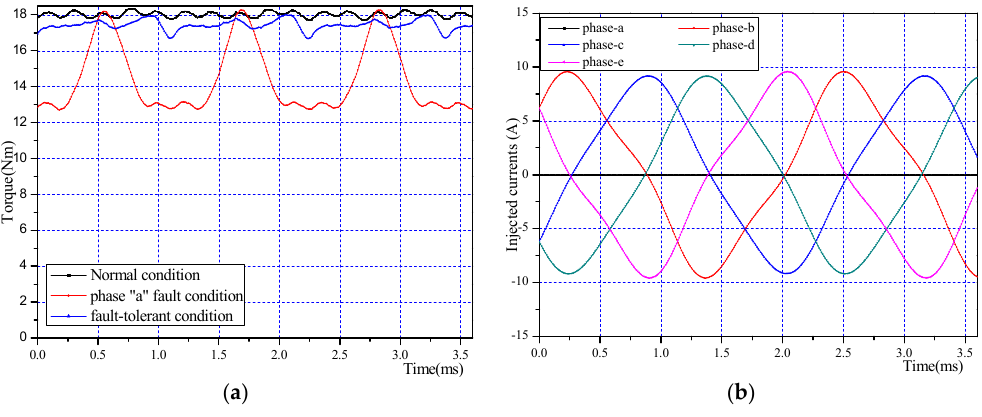
Figure 5. The motor operates under single phase open circuit conditions: ( a ) the electromagnetic torque obtained by finite element analysis (FEA); ( b ) the injected fault ‐ tolerant currents.